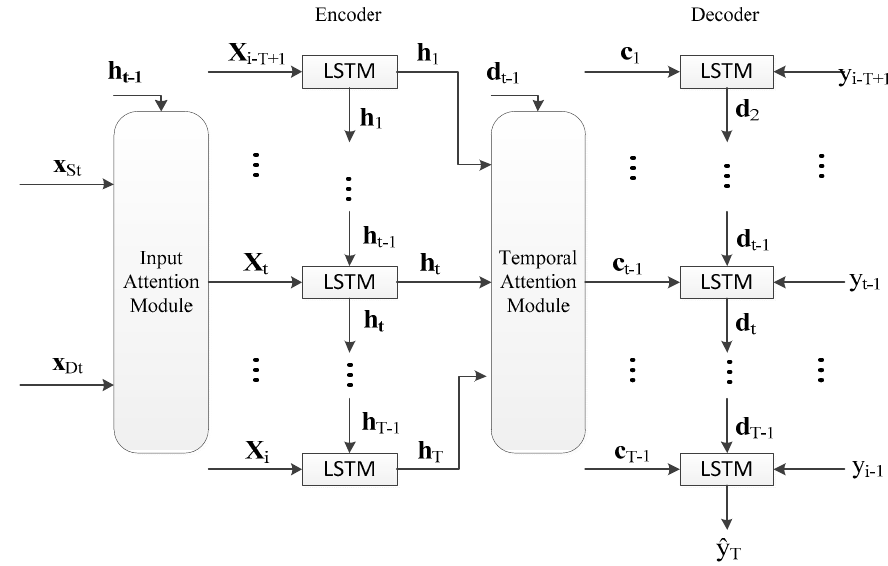
Figure 1. The prediction model is a dual-stage attention-based recurrent neural network.